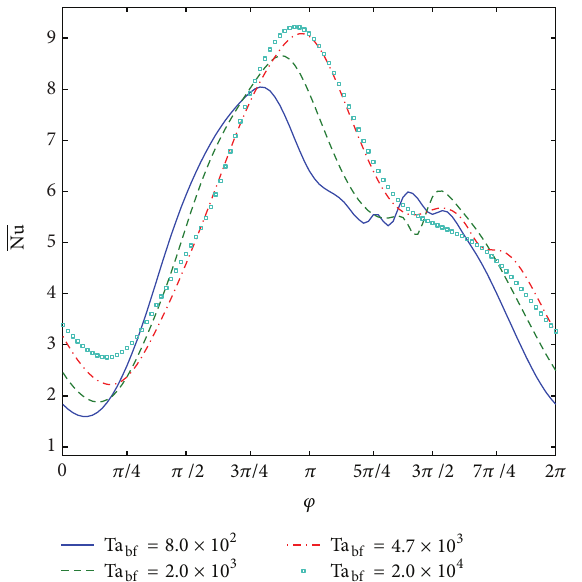
Figure 9: Plots of the time-integrated average Nusselt number against the volume fraction for the values of Ta bf labeled on the figure for water-Cu.